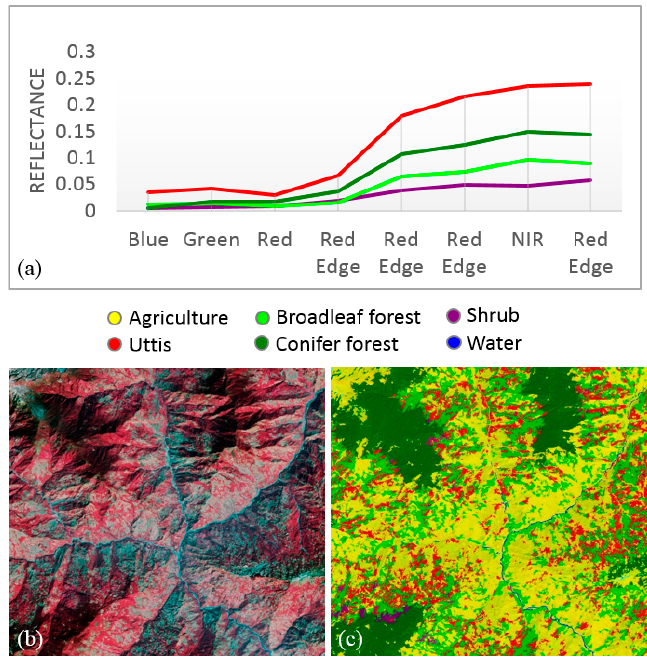
Figure 3. ( a ) Spectral separability of vegetation, ( b ) Sentinel ‐ 2A satellite image (False color), ( c ) object ‐ based classification of satellite data.